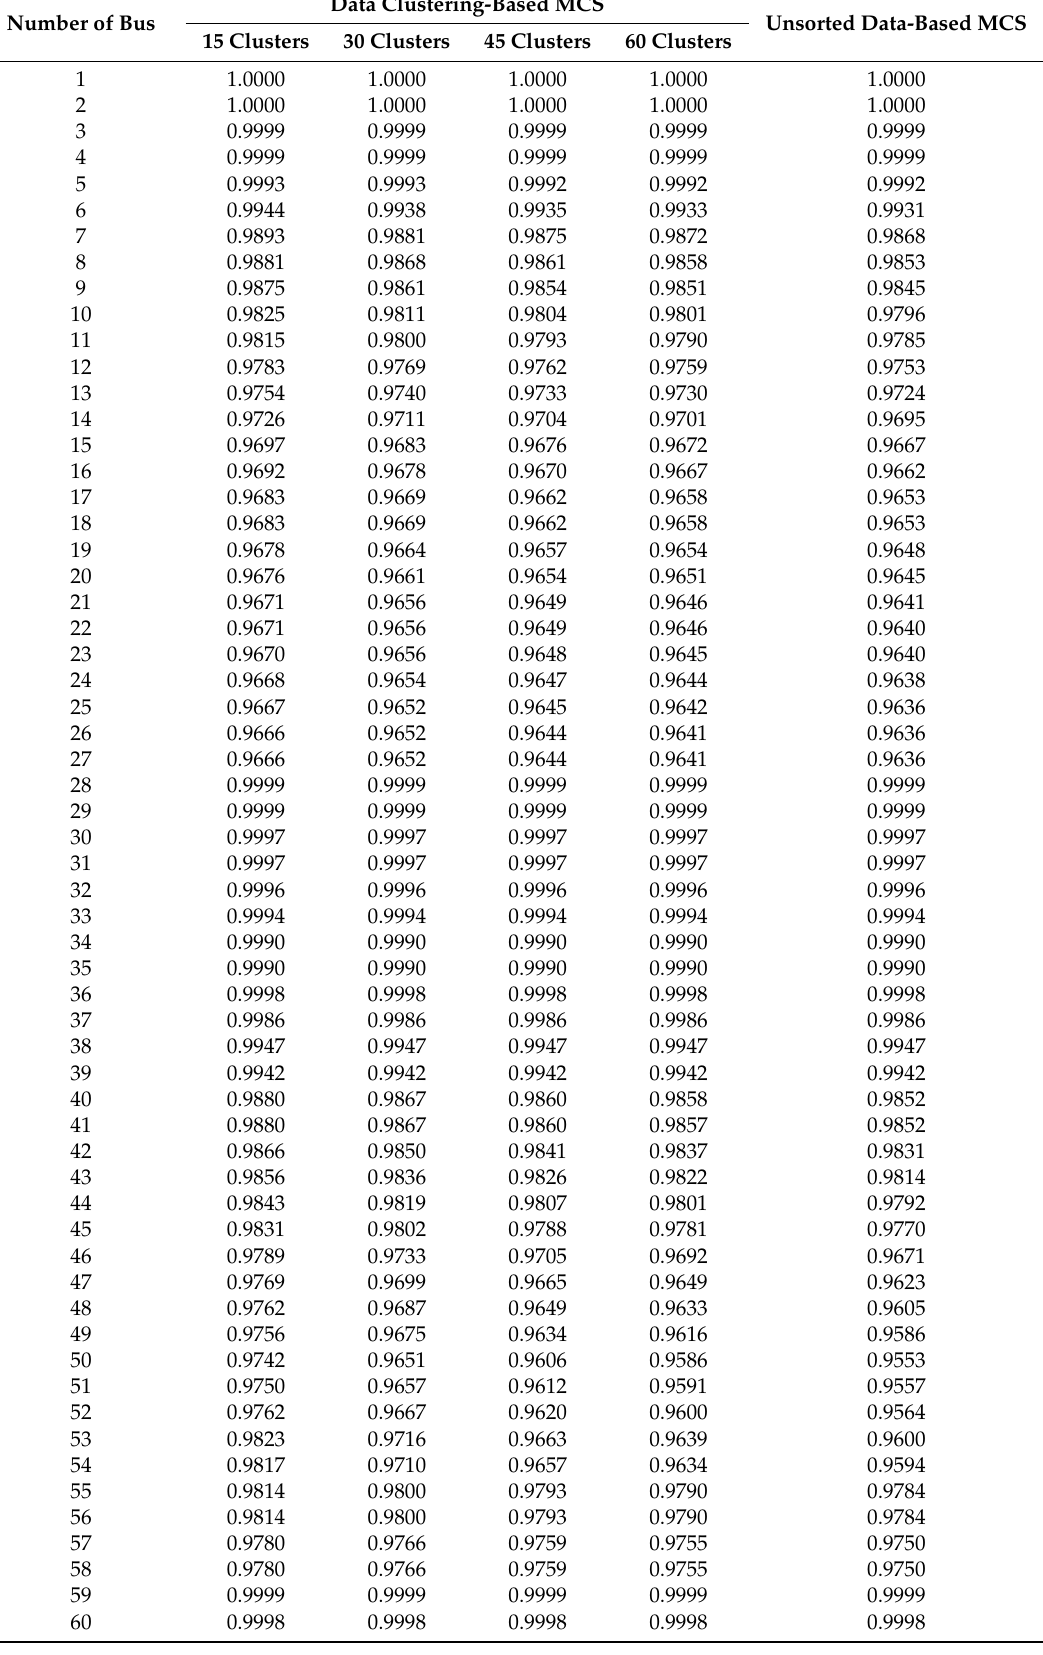
Table 7. Voltage magnitudes with the proposed data clustering-based direct PLF (69-bus